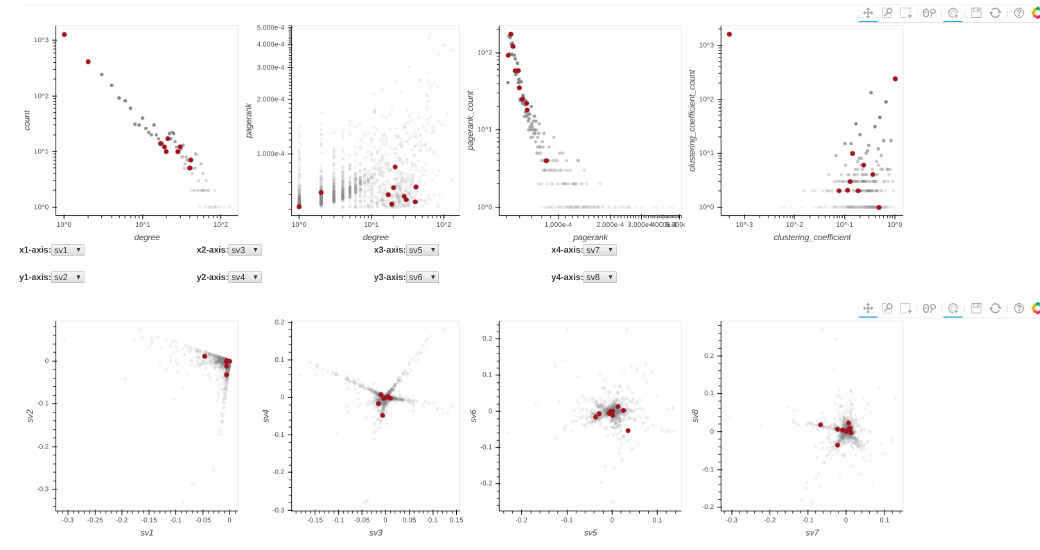
Figure 9. Top ten anomalous nodes are highlighted in